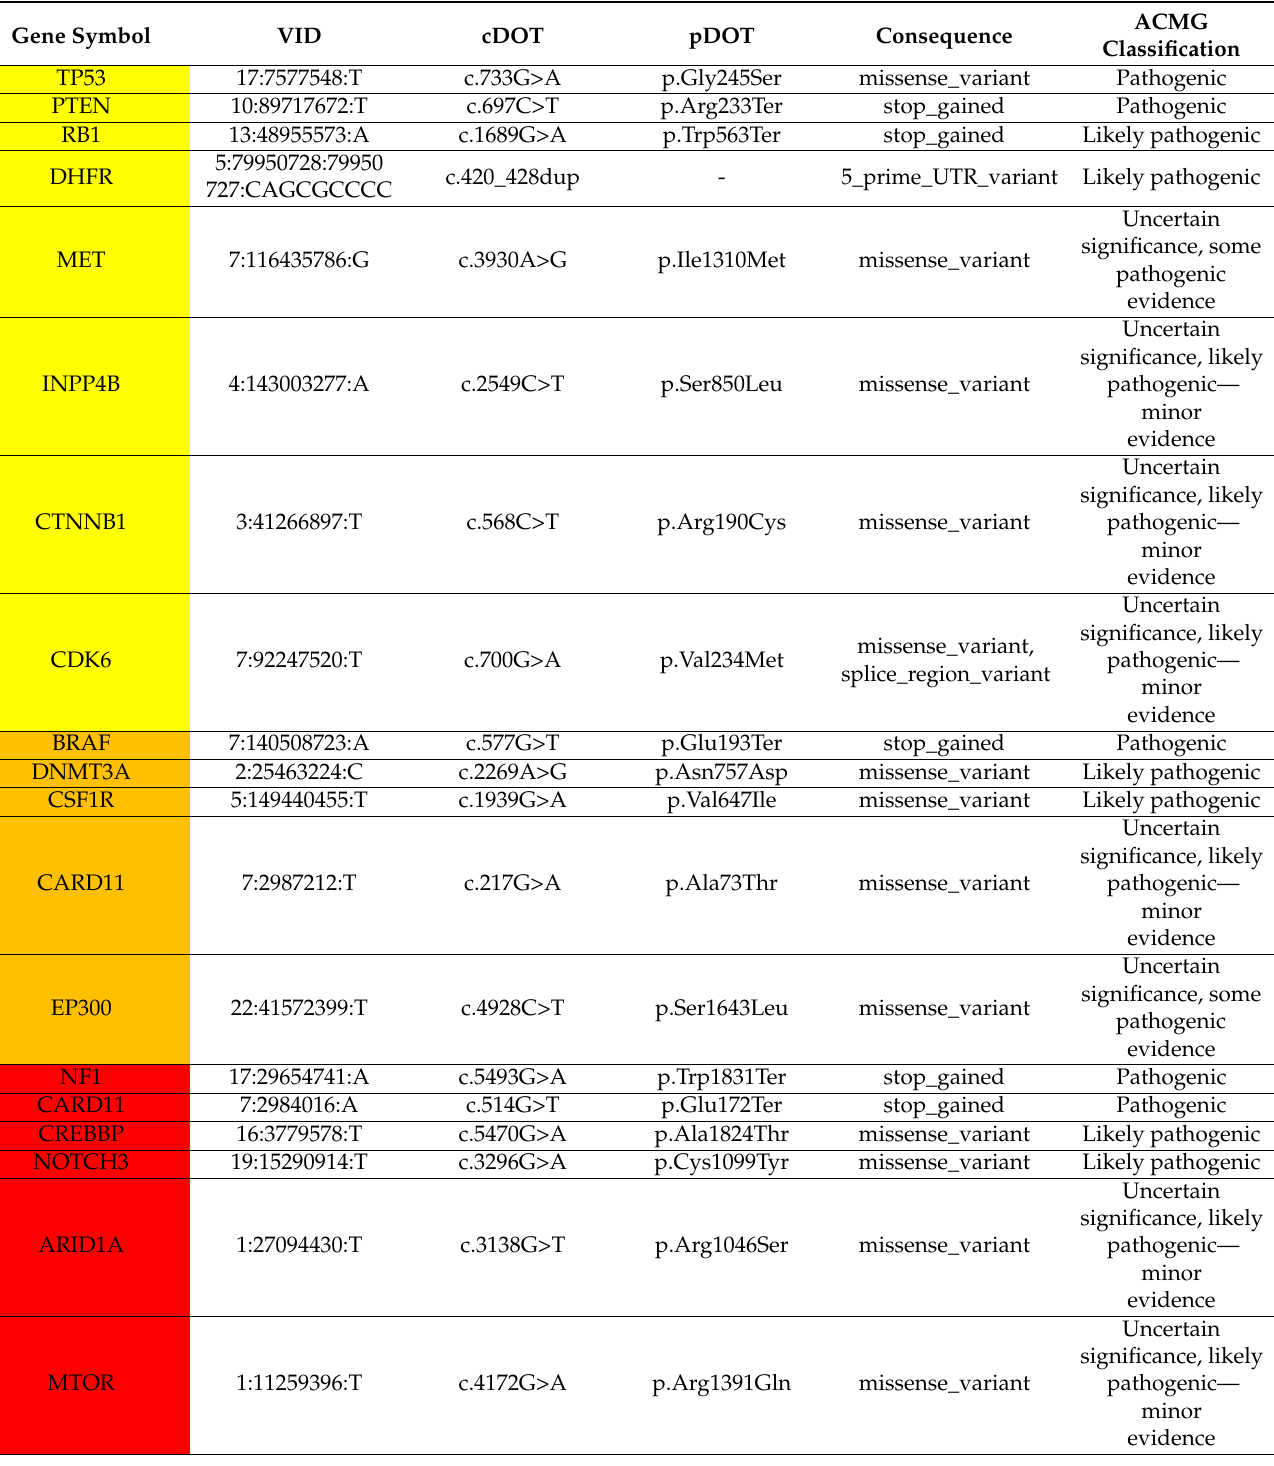
Table 1. List of gene alterations detected by the NGS sequencing of the primary and metastatic GBM. Genetic alterations are separated based on their occurrence in the tumor samples. Yellow highlighted genes are genetic alterations shared by both primary and metastatic GBM. Altered genes identified only in the primary GBM are labeled orange. Altered genes detected only in the metastatic GBM are labeled